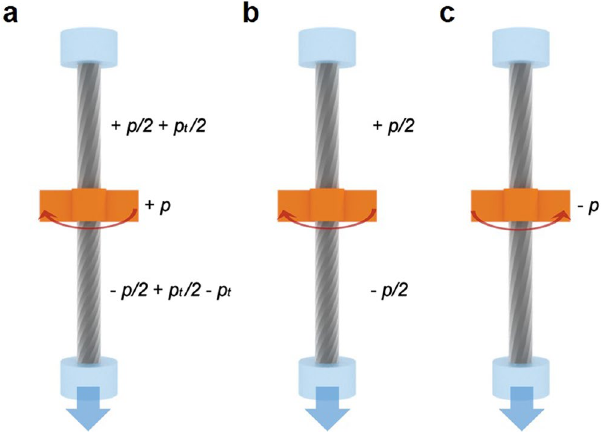
Figure 10. Schematic diagram explaining the rotational behavior of the two-ended tethered CNT yarn. ( a ) Additional untwist ( − p t , tension-induced untwist) is introduced to the lower part of the CNT yarn when further retwisting ( + p ) proceeds. ( b ) Additional untwist is transferred from the upper part to the lower part, cancelling the additional twist developed in the previous untwist in Figs 8c and 9b. The CNT yarn returns to the original state as the second untwisting operation